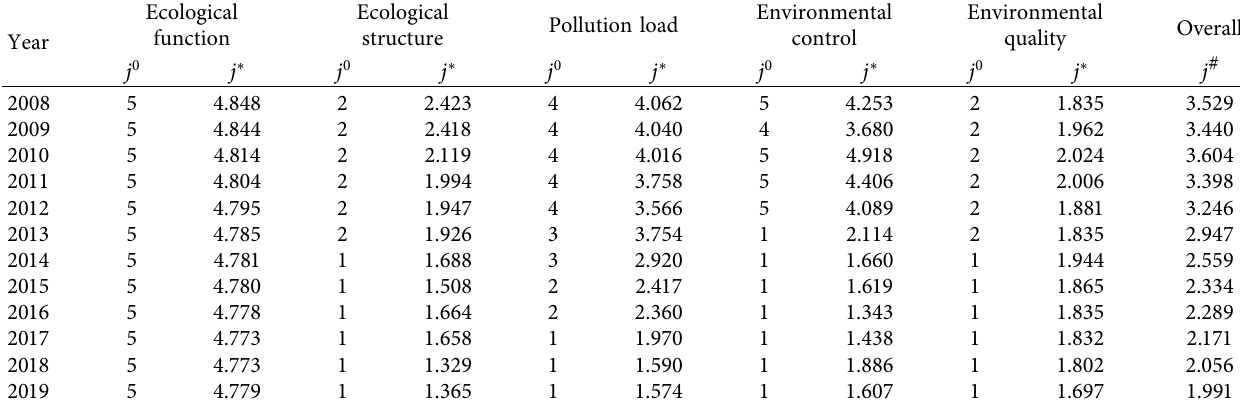
Table 3: The eigenvalues and comprehensive eigenvalues of the first-level indicators of environmental quality in Zhangjiakou Ecological Conservation Zone.